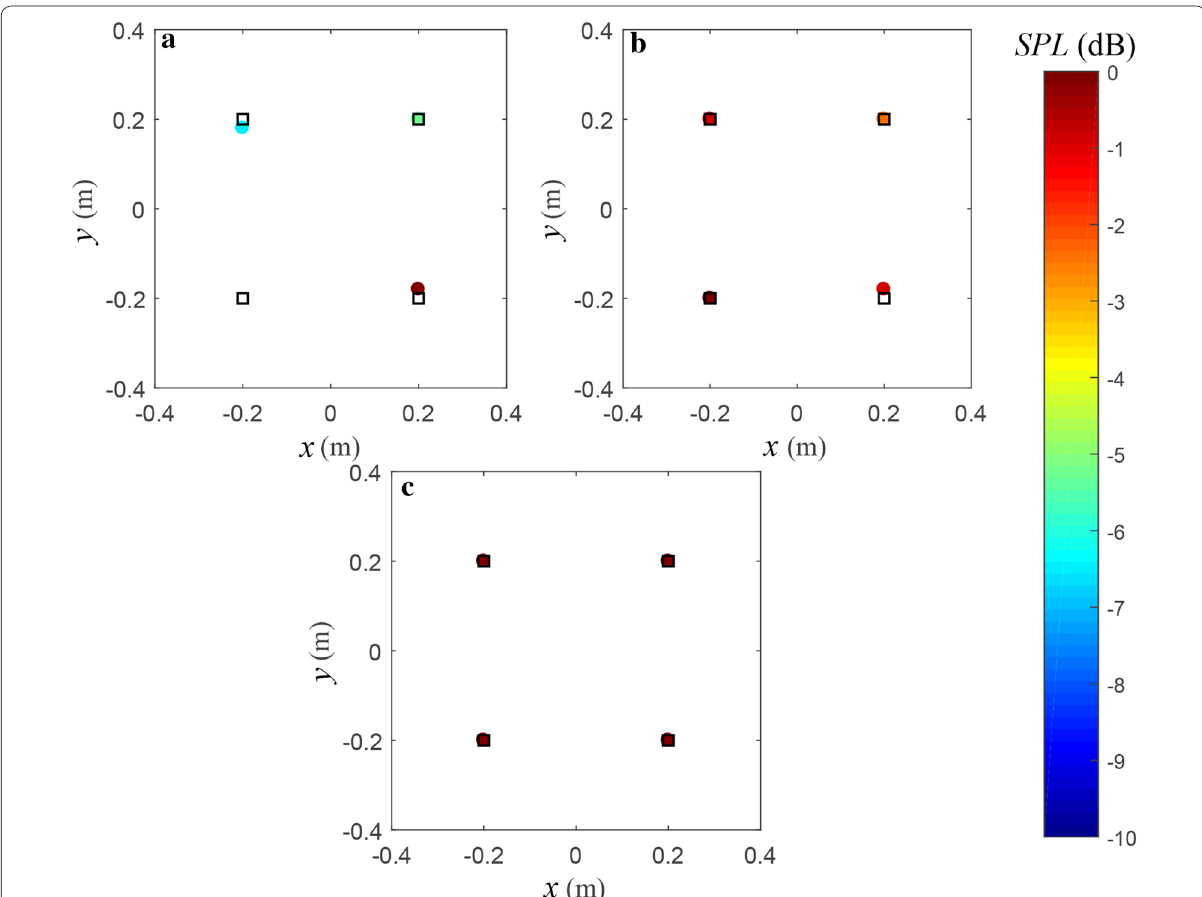
Figure 5 Source maps and the CPU-time obtained by: a Wideband BP method (134.4 s), b DCS-SOMP method (1.256 s), c DCS-SOMP-SVD method (2.759 s) when the SNR equals 0